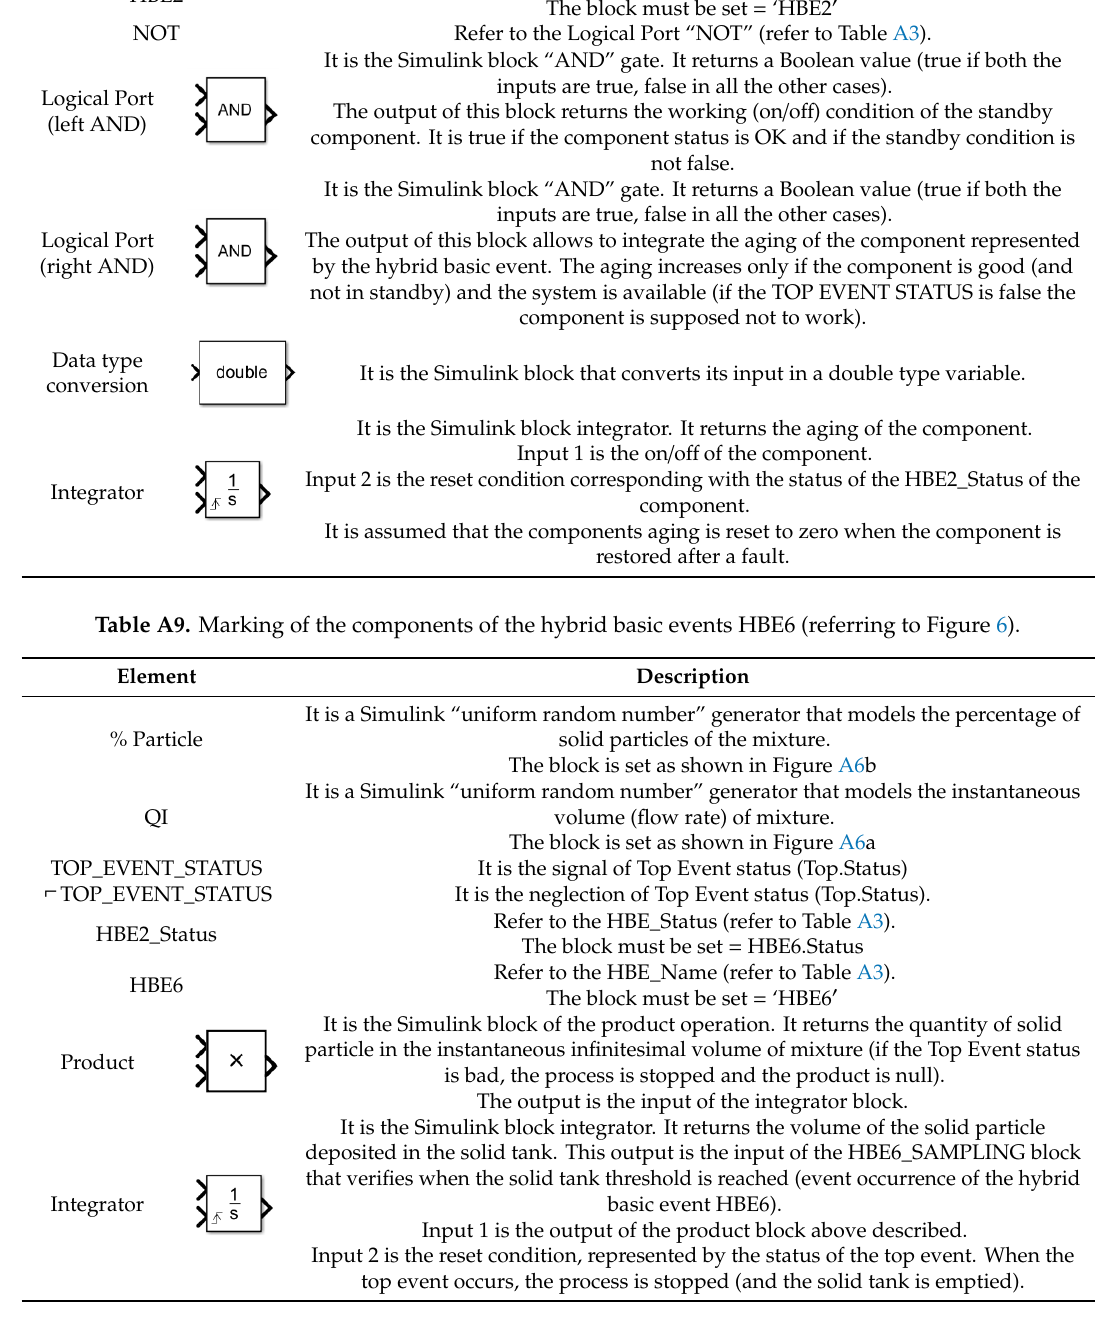
Figure A6. Block Parameters for the variables ( a ) QI and ( b ) % particle. In order to avoid the repetition of iterations with the same evolution (for the correct implementation of a Monte Carlo simulation), the Seed parameter must be set with a random number. This feature can be obtained by using a global array variable randomSeed that is initialized at the beginning of each new iteration (as previously described in the script << SHyFTAmain.m>> ). Table A10. Marking of the components of the physical process (referring to Figure 8). Element Description